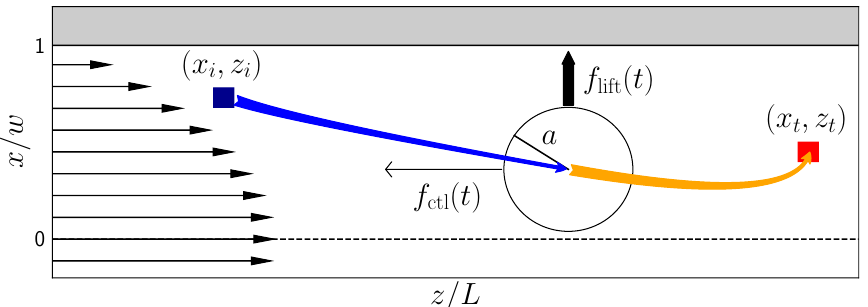
Figure 1. Sketch of the model system: a colloid flowing in the x - z plane experiences an axial control force f ctl ( t ) . The occuring Saffman effect changes the lateral lift force f lift and, thereby, the colloid can be steered from the initial position ( z i , x i ) to the target ( z t , x t )